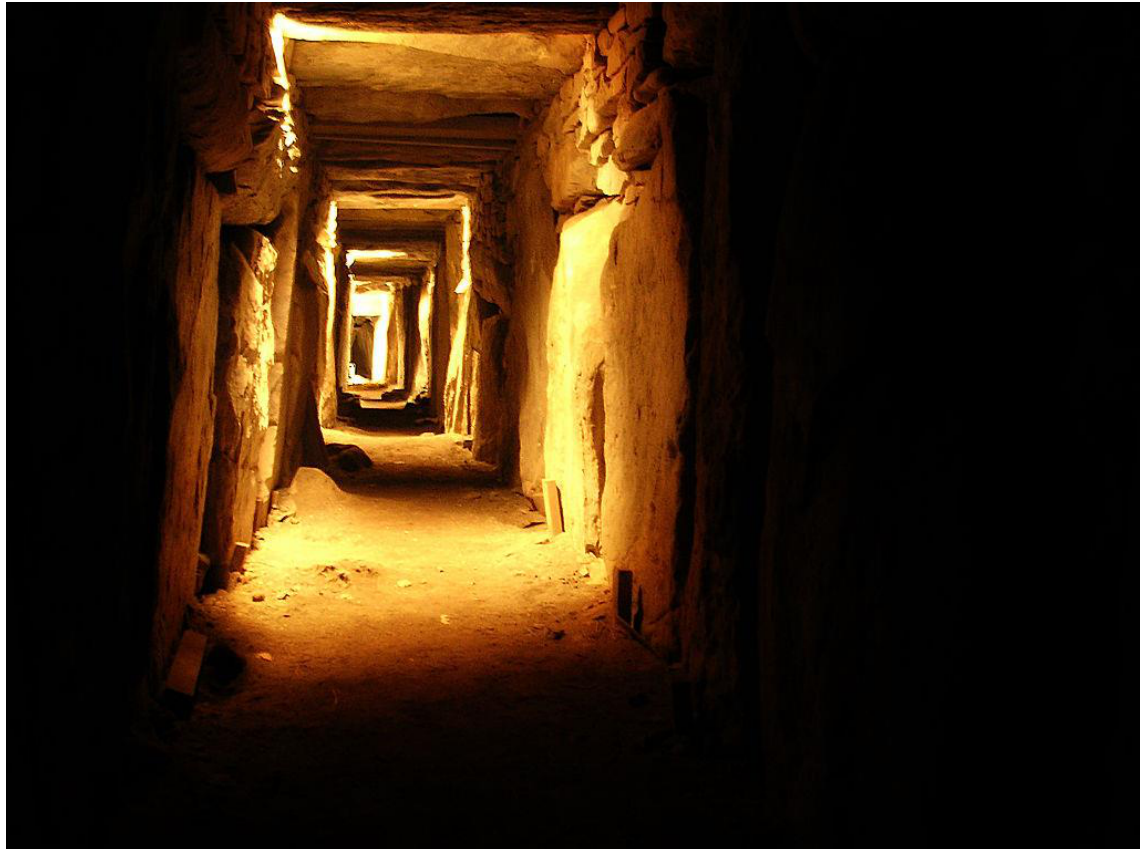
Figure 2. Eastern Passage, Knowth, County Meath, Ireland. (Photo by P. Sakradja